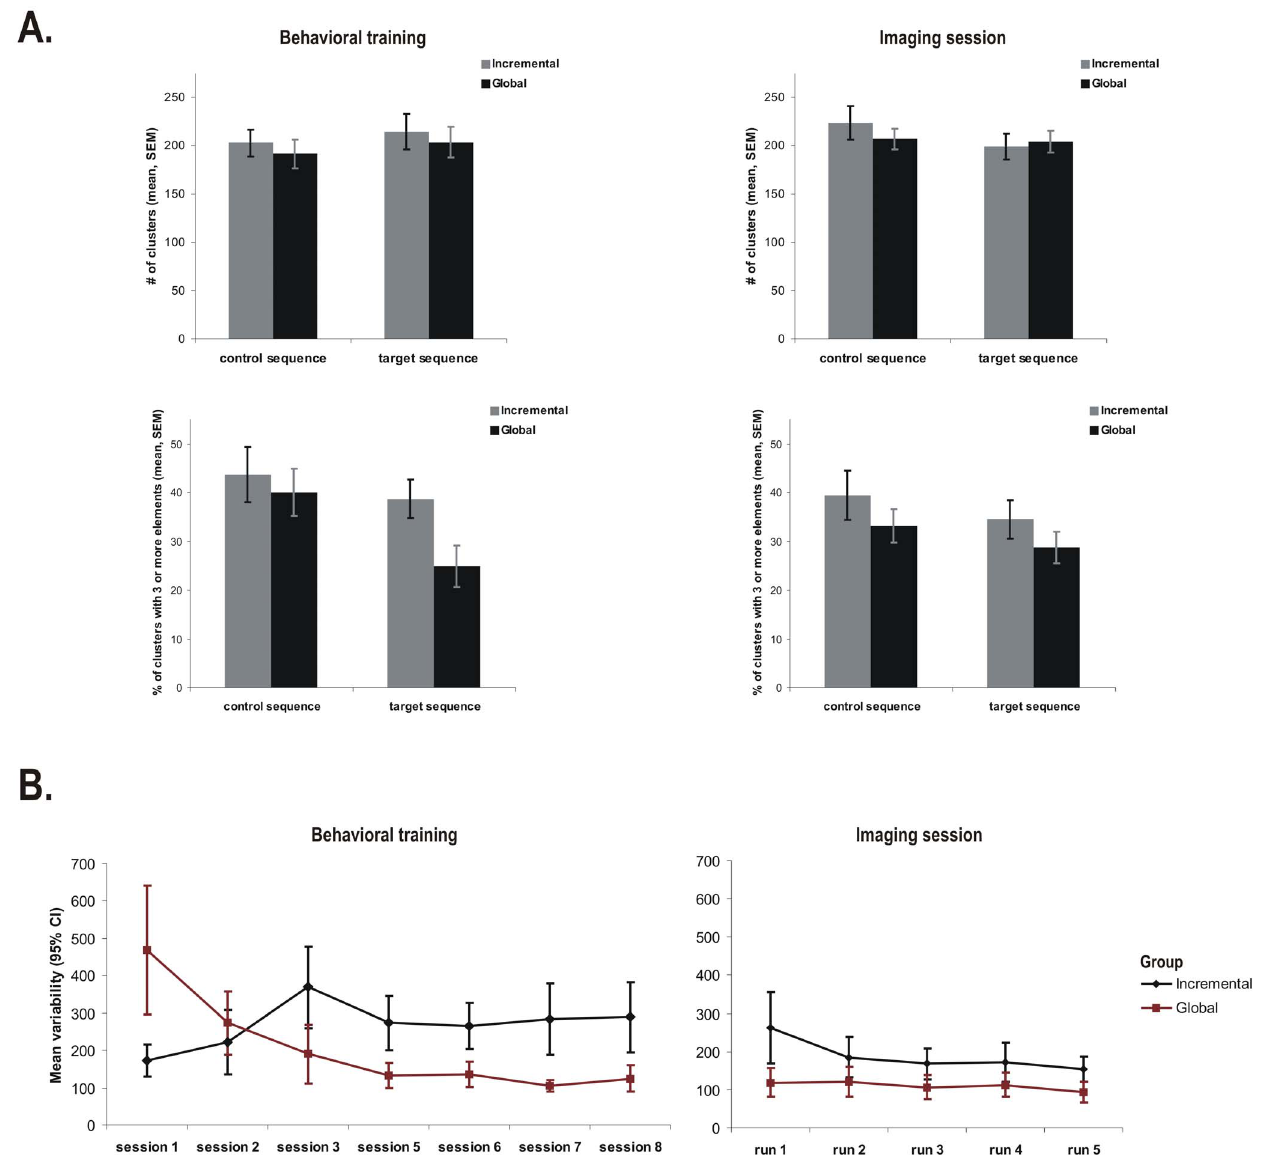
Figure 3. Sequence chunking and variability of performance. A. Mean number of clusters (first row) and the percentage of clusters with 3 or more elements (second row) in session 8th (left, behavioral) and 9th (right, imaging), for participants in the two groups. B. The mean variability in motor performance during the execution of the target sequence during 8 behavioral training sessions (left) and neuroimaging runs, during 9th session (right).